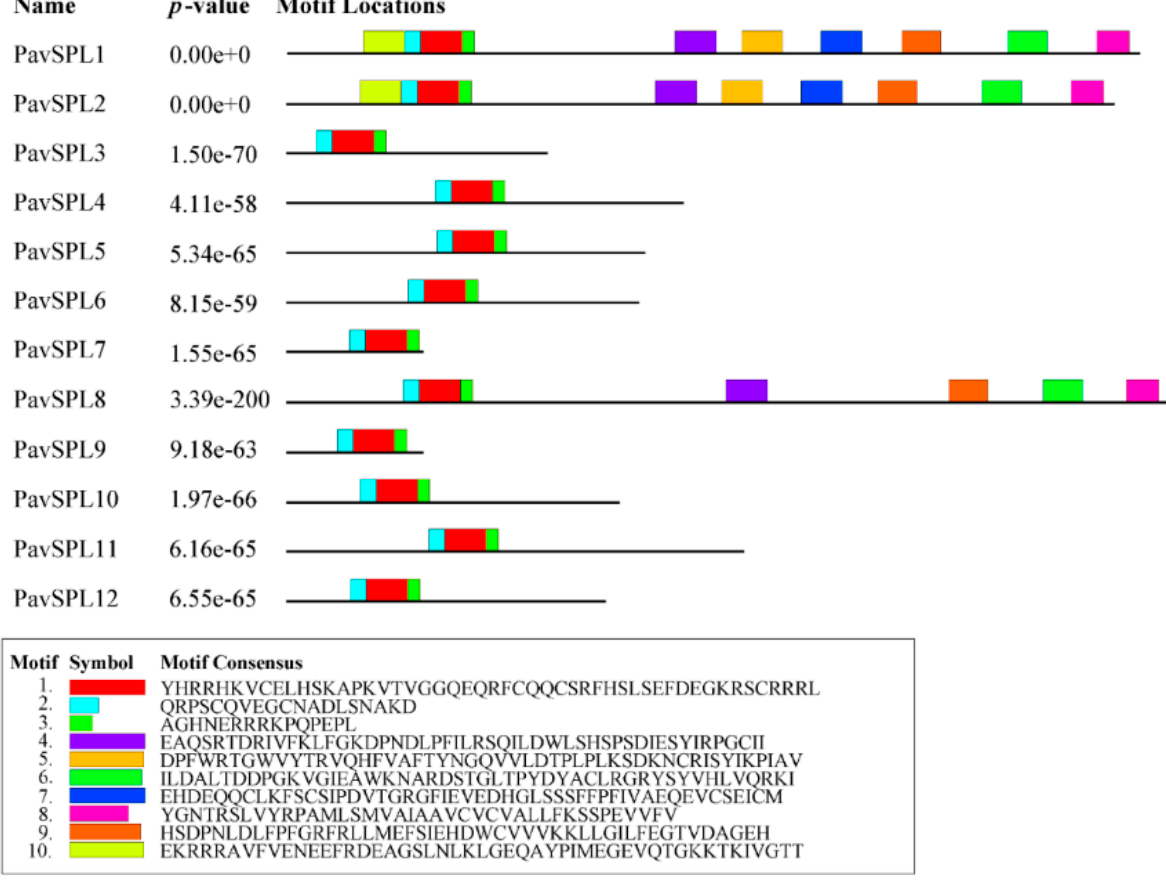
Figure 4. Motif composition of PavSPL proteins. Motifs of PavSPL proteins were analyzed using s MEME analysis. The ten motifs are represented by different colors.